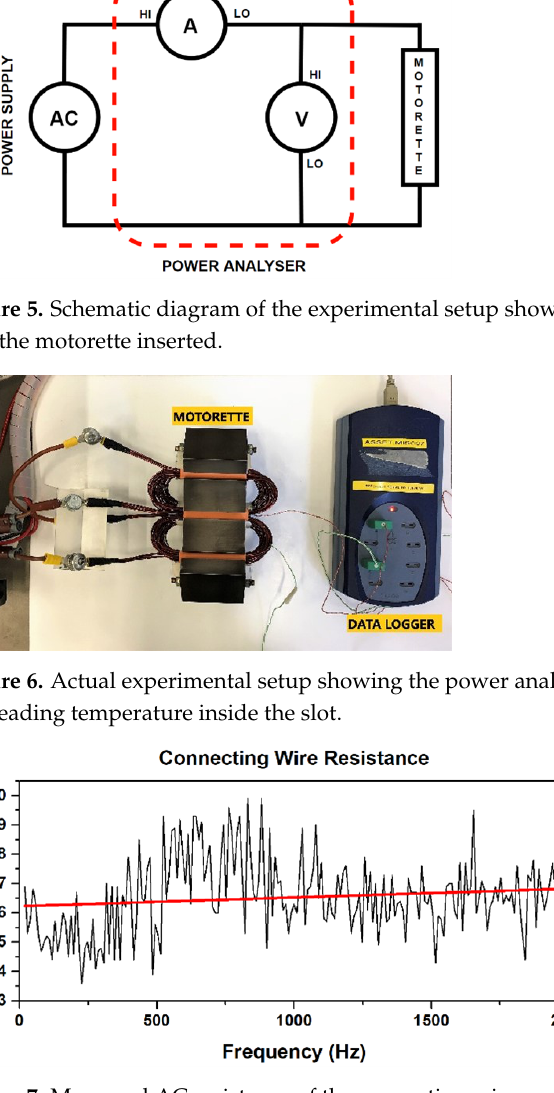
Figure 7. Measured AC resistance of the connecting wire against the